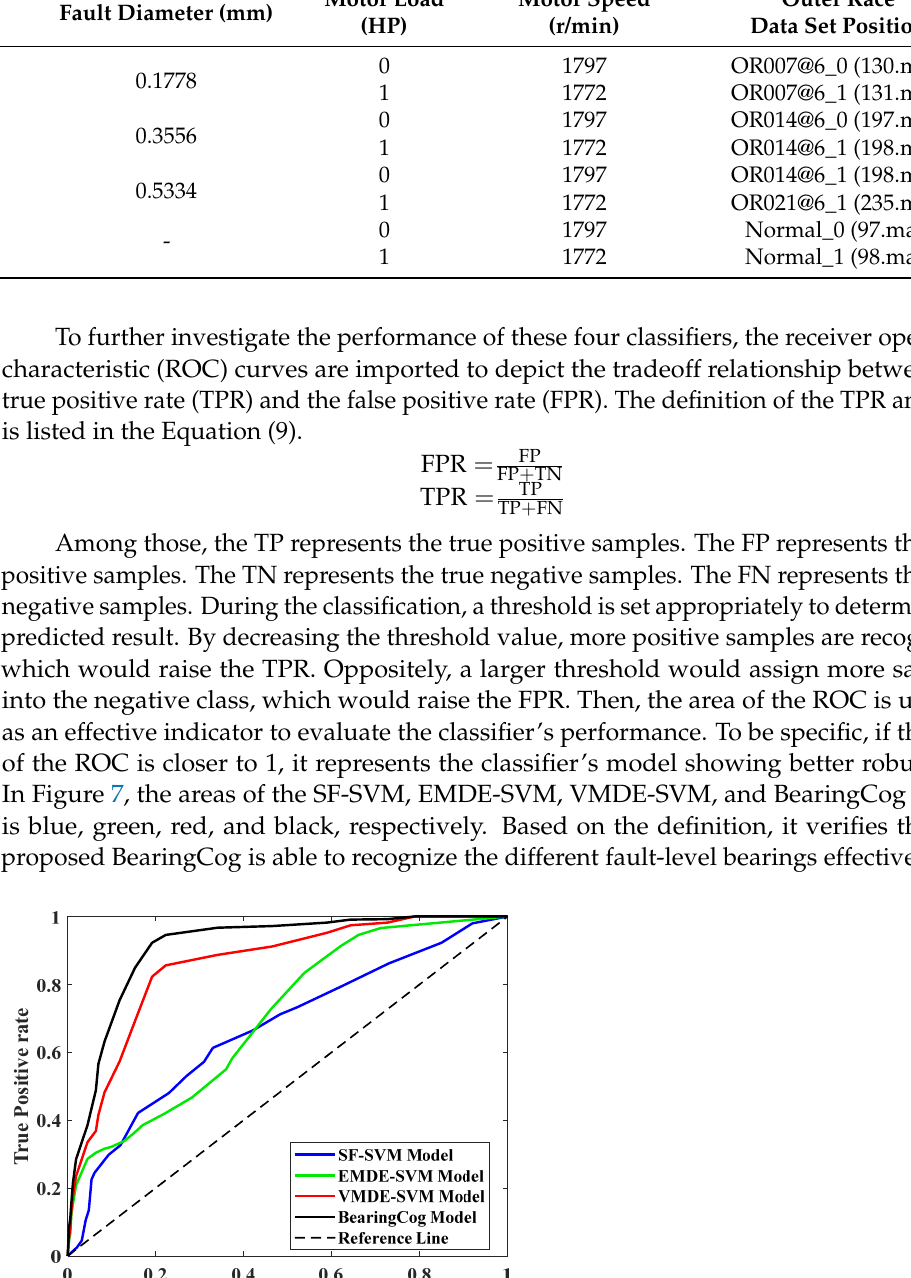
( d ) Figure 8. The projection effect of test samples under different data feature samples: ( a ) based on dimensionless time domain characteristics, ( b ) based on EMD decomposition energy, ( c ) based on VMD decomposition energy, and ( d ) based on multi-information fusion.